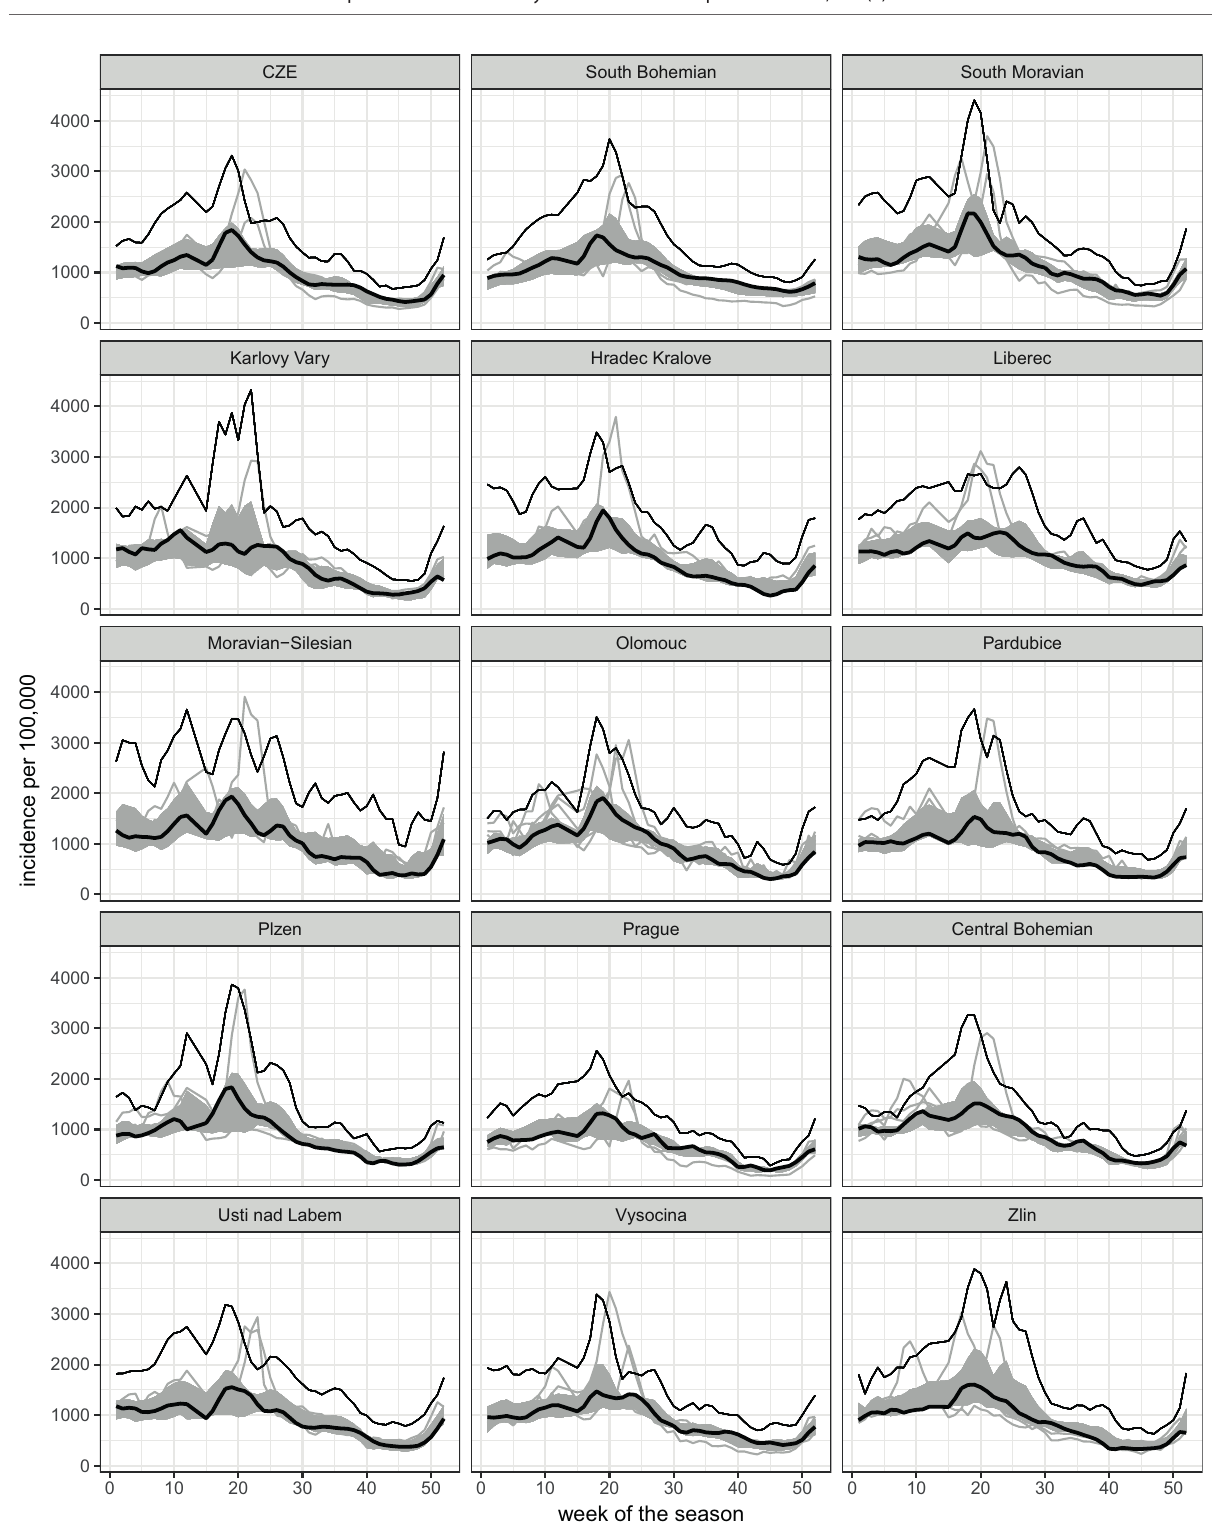
Fig. 2. Boxplots of ARI incidences in the Czech Republic and its regions,